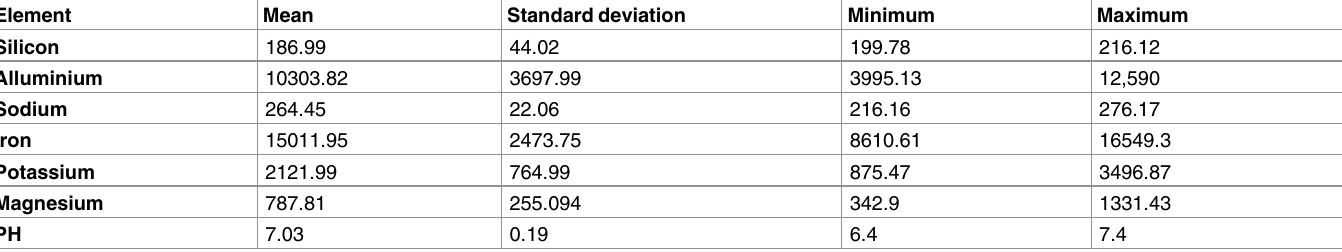
Table 5. Overall mean, standard deviation, minimum and maximum values of soil element concentration in mg/kg and soil PH in soil sampled in Mt Longonot area. Element